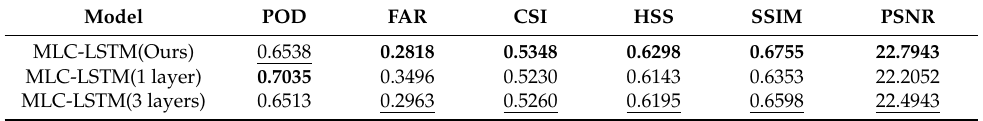
Figure 5. The extrapolation results for the echo at Hangzhou, China, 8 August 2016, 23:07 UTC. The last three rows show the results obtained by our model, MLC-LSTM with one layer, and MLC-LSTM with three layers, respectively. Table 2. Quantitative evaluation results of three models on six metrics. The mean value of six metrics of all 15 extrapolation steps is reported. The figures with bold-face indicate the best while the figures with underline indicate the second.